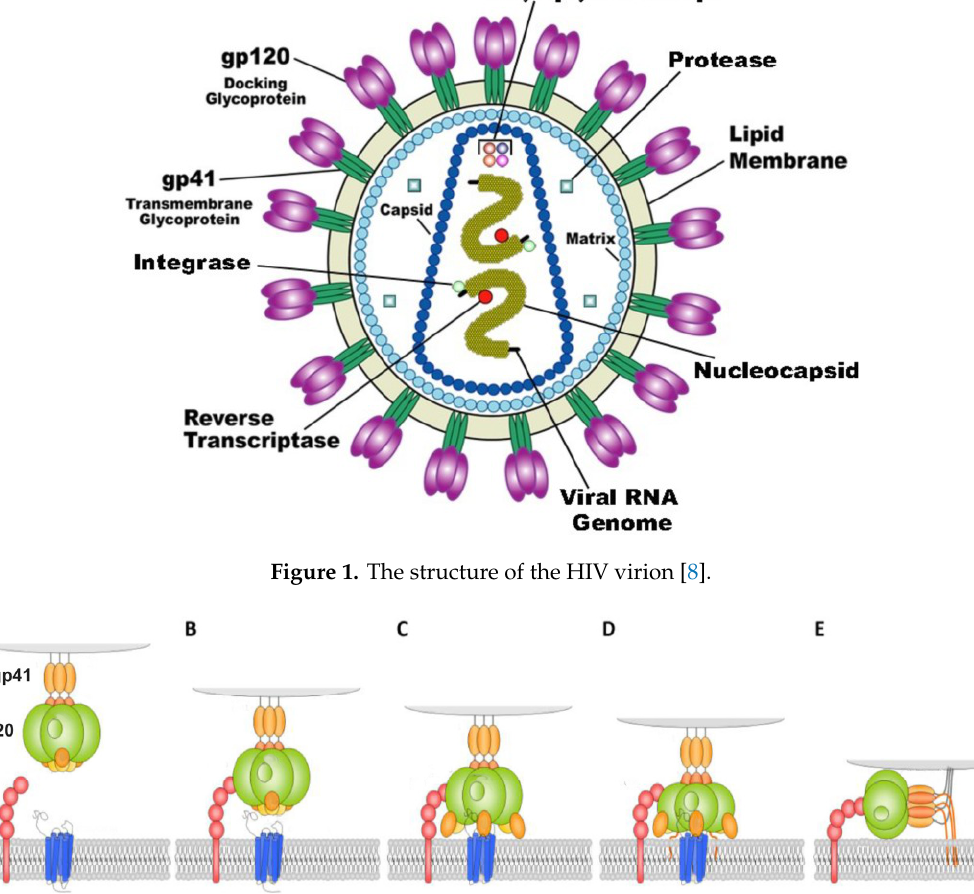
Figure 2. Model for HIV-1 entry. ( A , B ) Binding of cluster of di ff erentiation (CD)4 to glycoprotein (gp)120 exposes a coreceptor binding site in gp120; ( C , D ) coreceptor binding causes the exposure of the gp41 fusion peptide and its insertion into the membrane of the target cell in a triple-stranded coiled-coil; and ( E ) formation of a helical hairpin structure in which gp41 folds back on itself is coincident with membrane fusion [9].